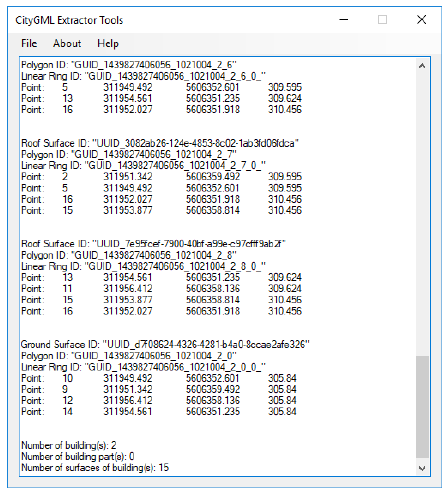
Figure 2. Two disjointed buildings (Dataset B) The buildings consisted of ground surfaces, wall surfaces, and roof surfaces. Each of these 2D surfaces are made up of 1D lines and 0D nodes that each have x, y, and z-coordinates. An example of the extracted geometrical properties from Dataset A and B are shown in Figure 3 and 4 respectively.